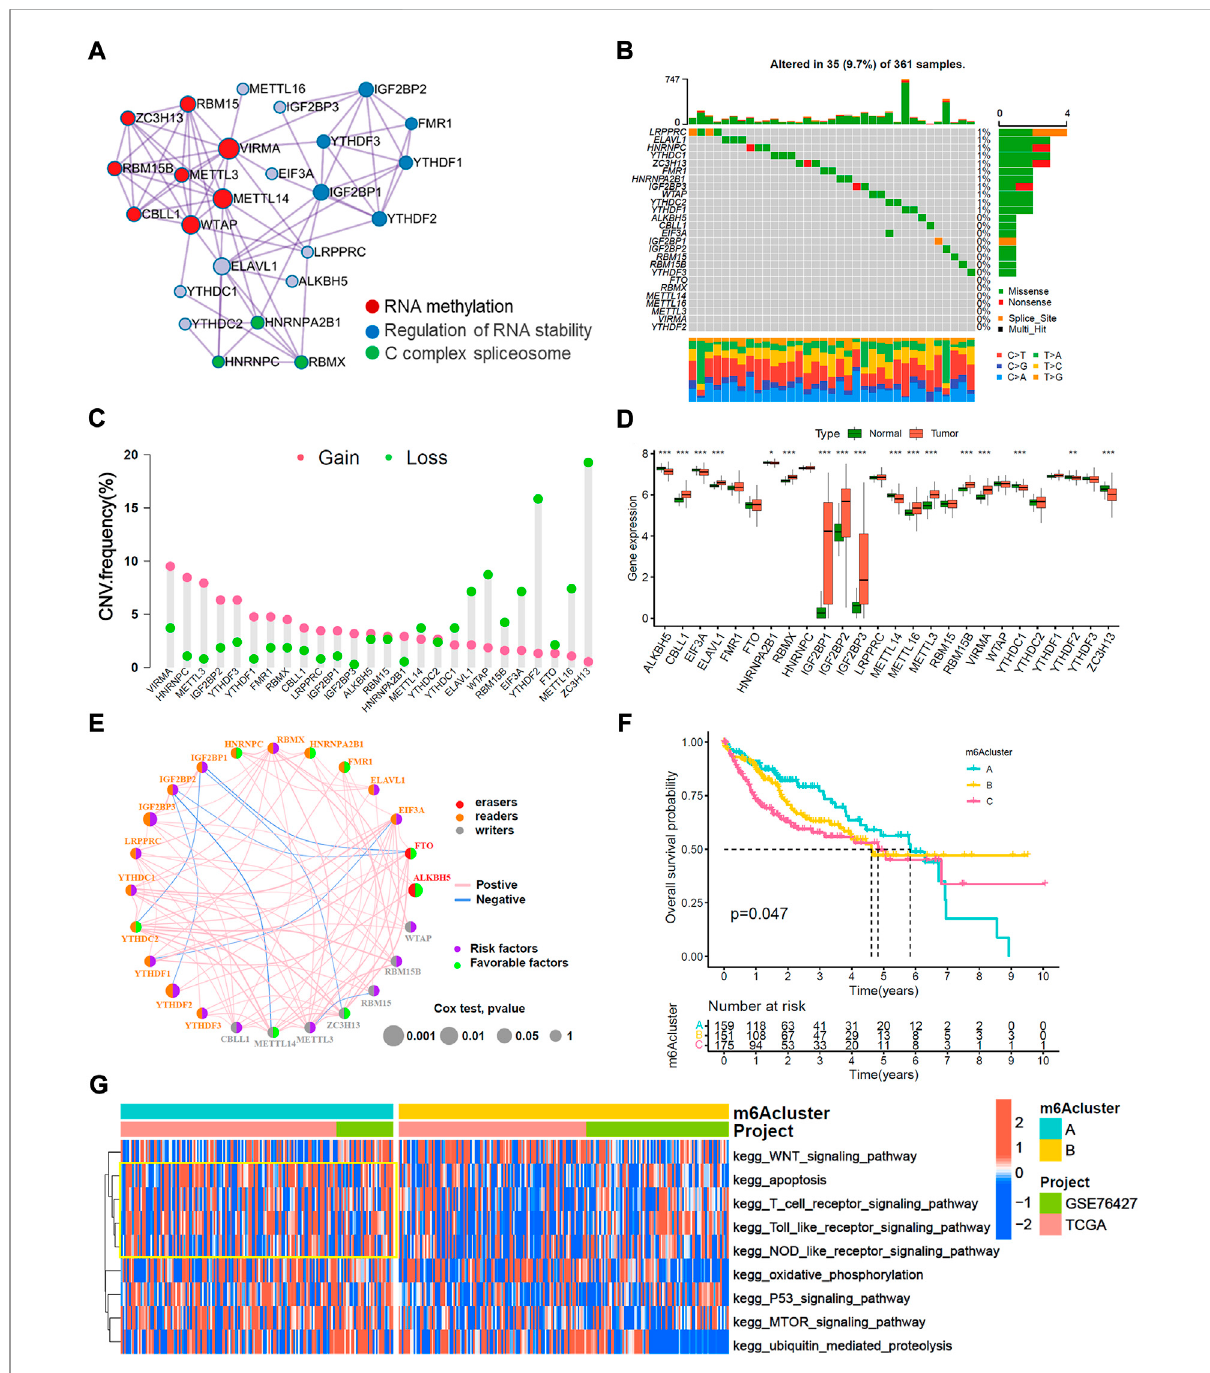
FIGURE 2 Multi-omics characteristic landscapesof26m6Aregulatorsandrelevant biologicalpathway ofm6Amodi fi cationpatterninHCC. (A) Theintra- clusters similarities of 26 m6A regulators were visualized by the metascape enrichment network, and the cluster annotations were presented with color code, including methylation, stability, and C complex spliceosome. (B) Genetic mutations landscape of 26 m6A regulators was found in 35of the 361 HCC patients, with a frequency of 9.7%, and the mutation frequency of each regulator were shown on the right. (C) The bar plot indicated the CNV alterations frequency of regulators in the TCGA-LIHC cohort. The ampli fi cation frequency was presented in pink dot, and the deletion frequency was in green dot. (D) The transcriptome landscape of regulators between normal and HCC samples in TCGA-LIHC cohort. The statistical p -value was showed by the asterisks above (ns, p > 0.05; * p < 0.05; ** p < 0.01; *** p < 0.001). (E) The interaction of expression on 24 m6A regulators were sequenced in both TCGA and GSE76427 HCC cohorts. The 24 m6A regulators were depicted into three RNA modi fi cation types by the left half of circle in different colors. Erasers, red, Readers, yellow; Writers, blue; and the lines connecting each m6A regulator represented